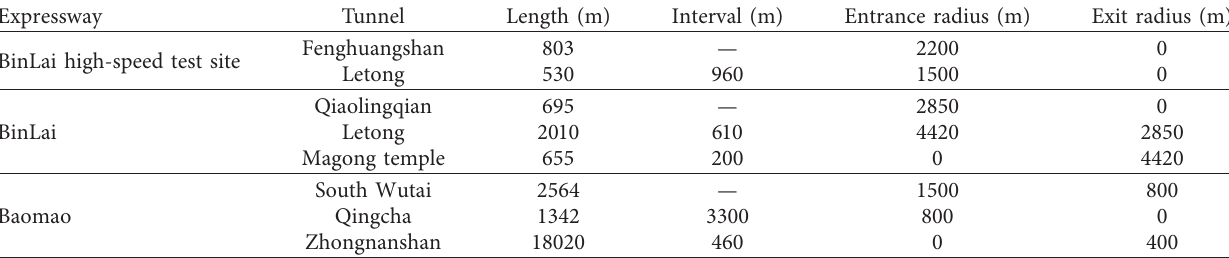
Table 1: The basic conditions of the tunnel (upward direction).